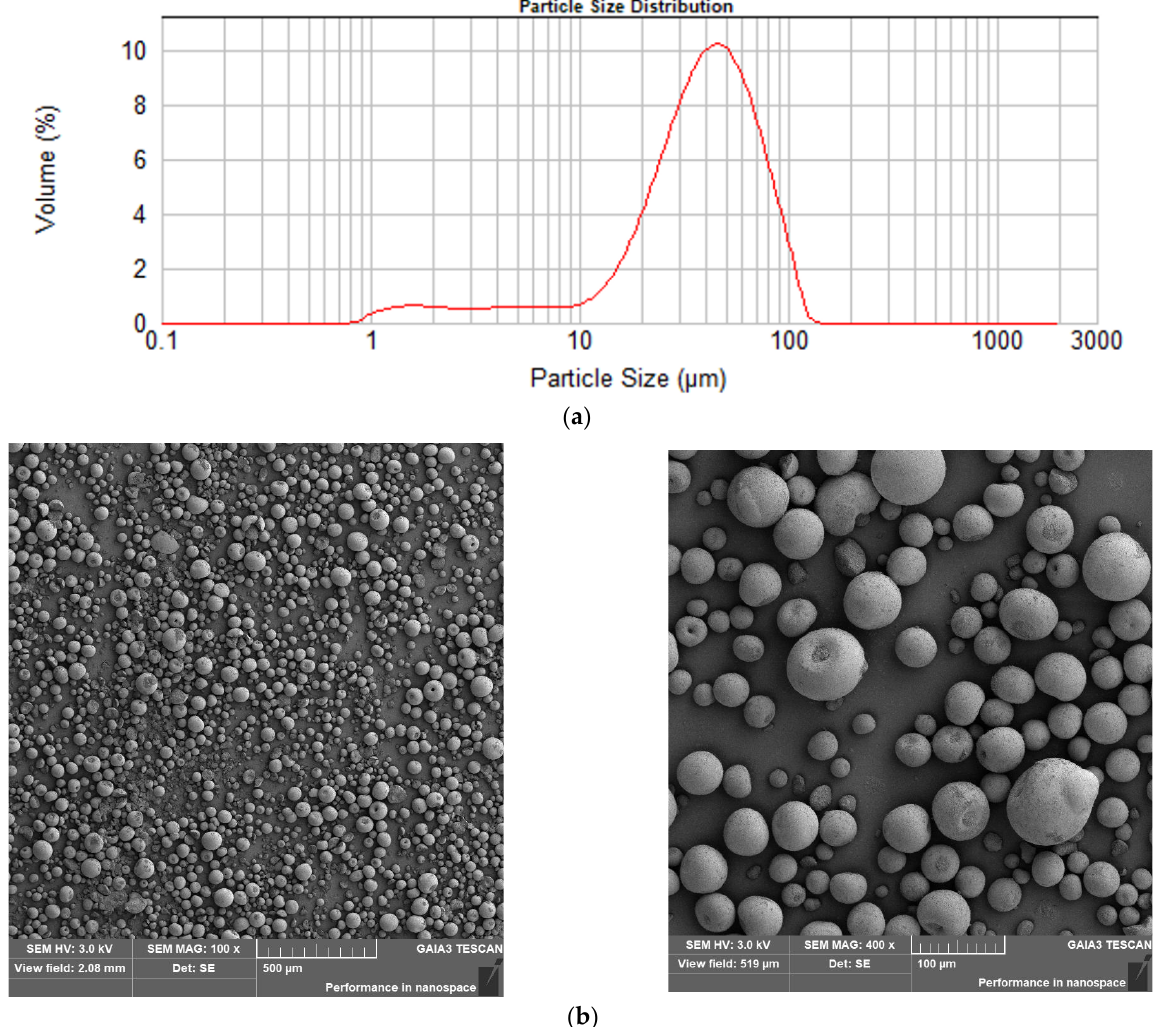
Figure 2. Spray dried alumina powder; ( a ) particle size distribution, ( b ) SEM images.